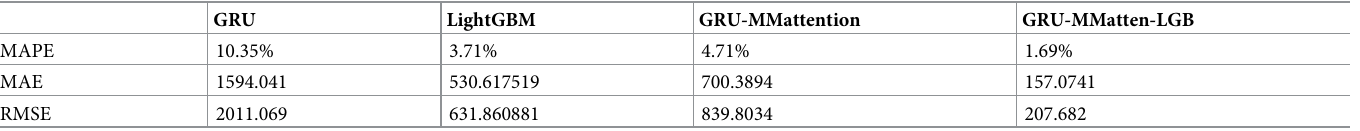
Table 4. Comparison of all optimal model results.